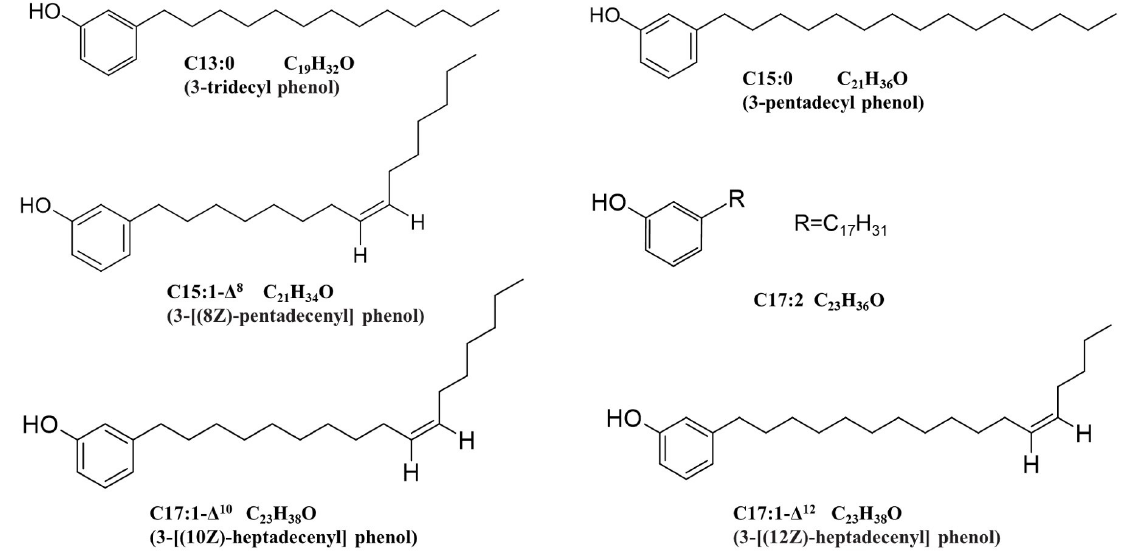
Figure 6. Structures of the ginkgol monomers.